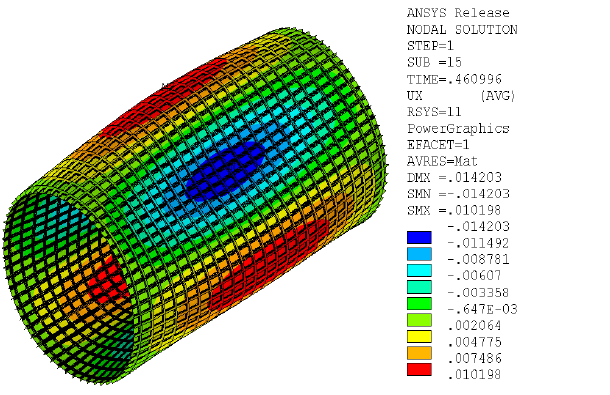
Figure 10. Comparison of the predicted and original load vs. end-shortening curves of the T-type stiffened cylinders with the SS3 boundary condition when the model material is AL.